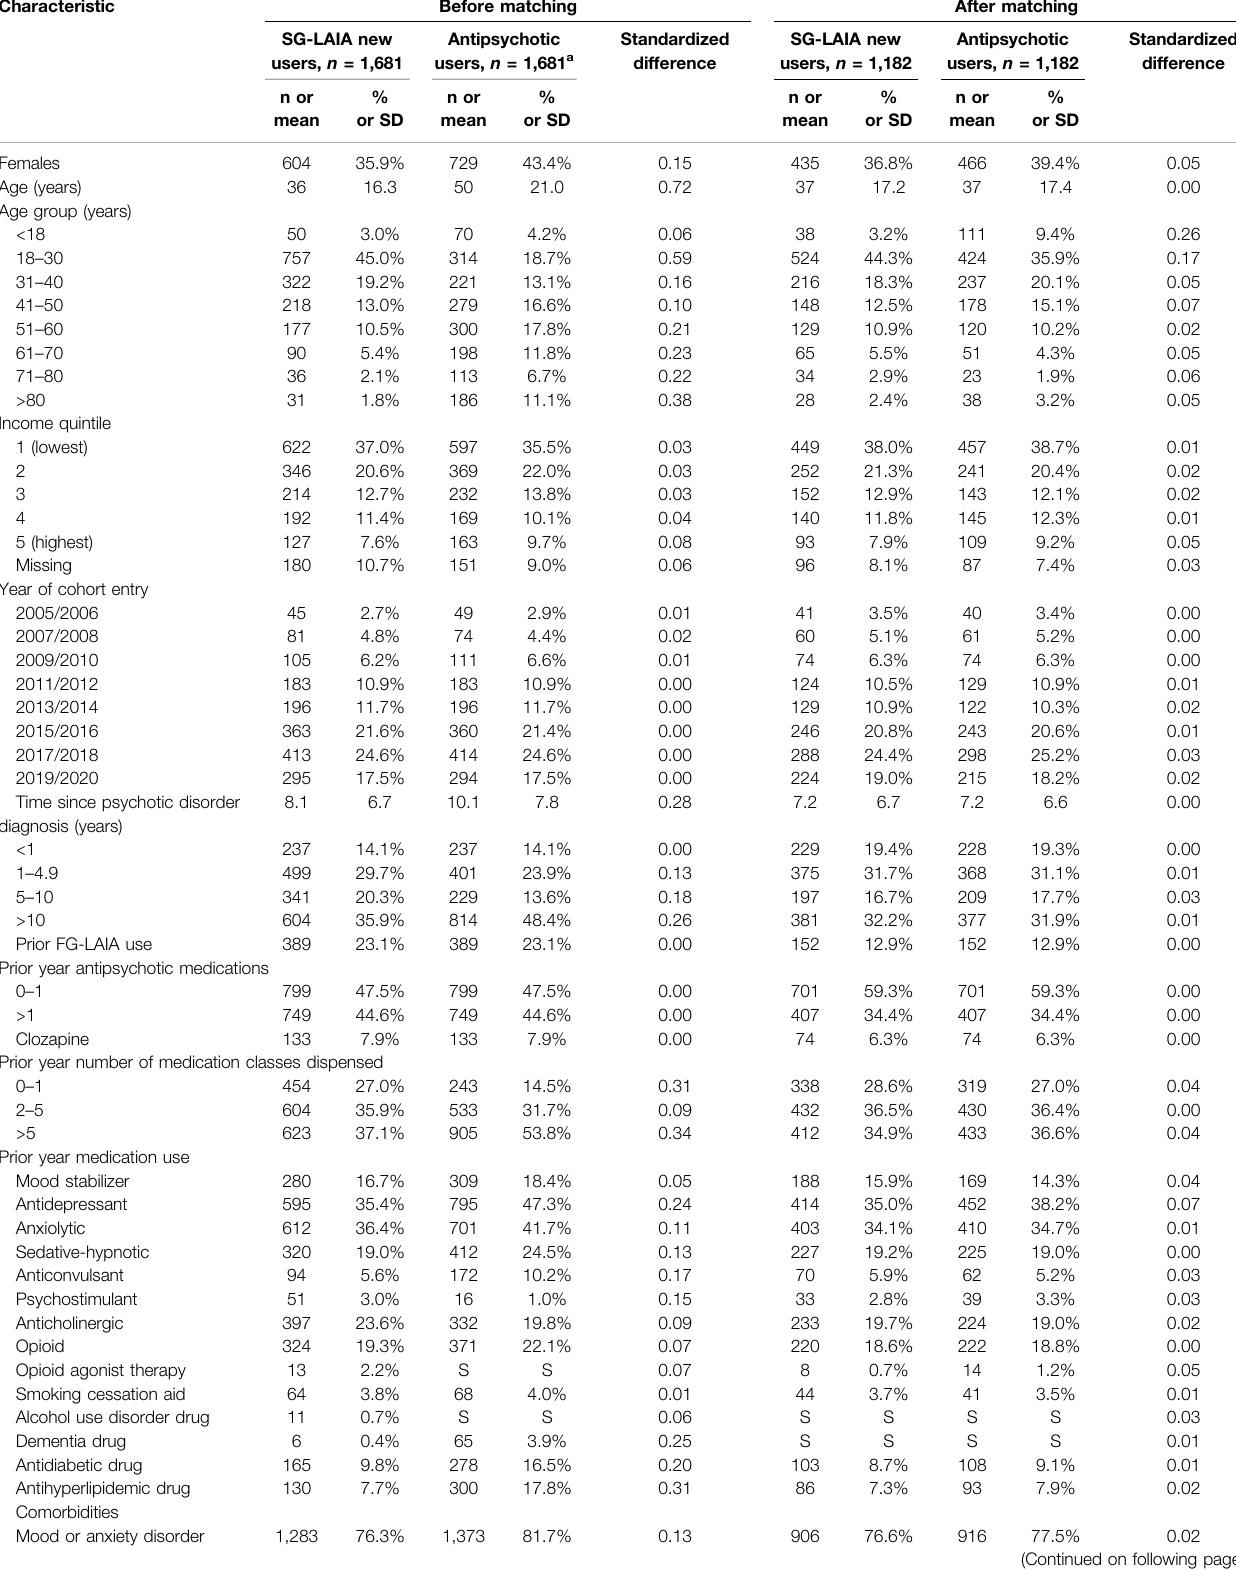
TABLE 1 | Baseline characteristics of cohort members before and after matching.